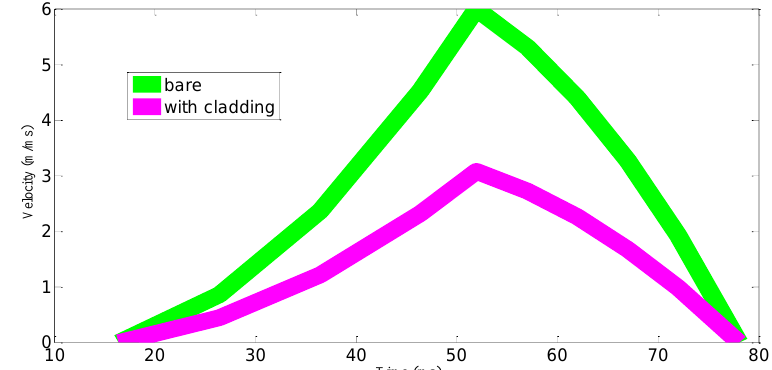
(b): Response of blast load on roof of velocity with and without cladding material.